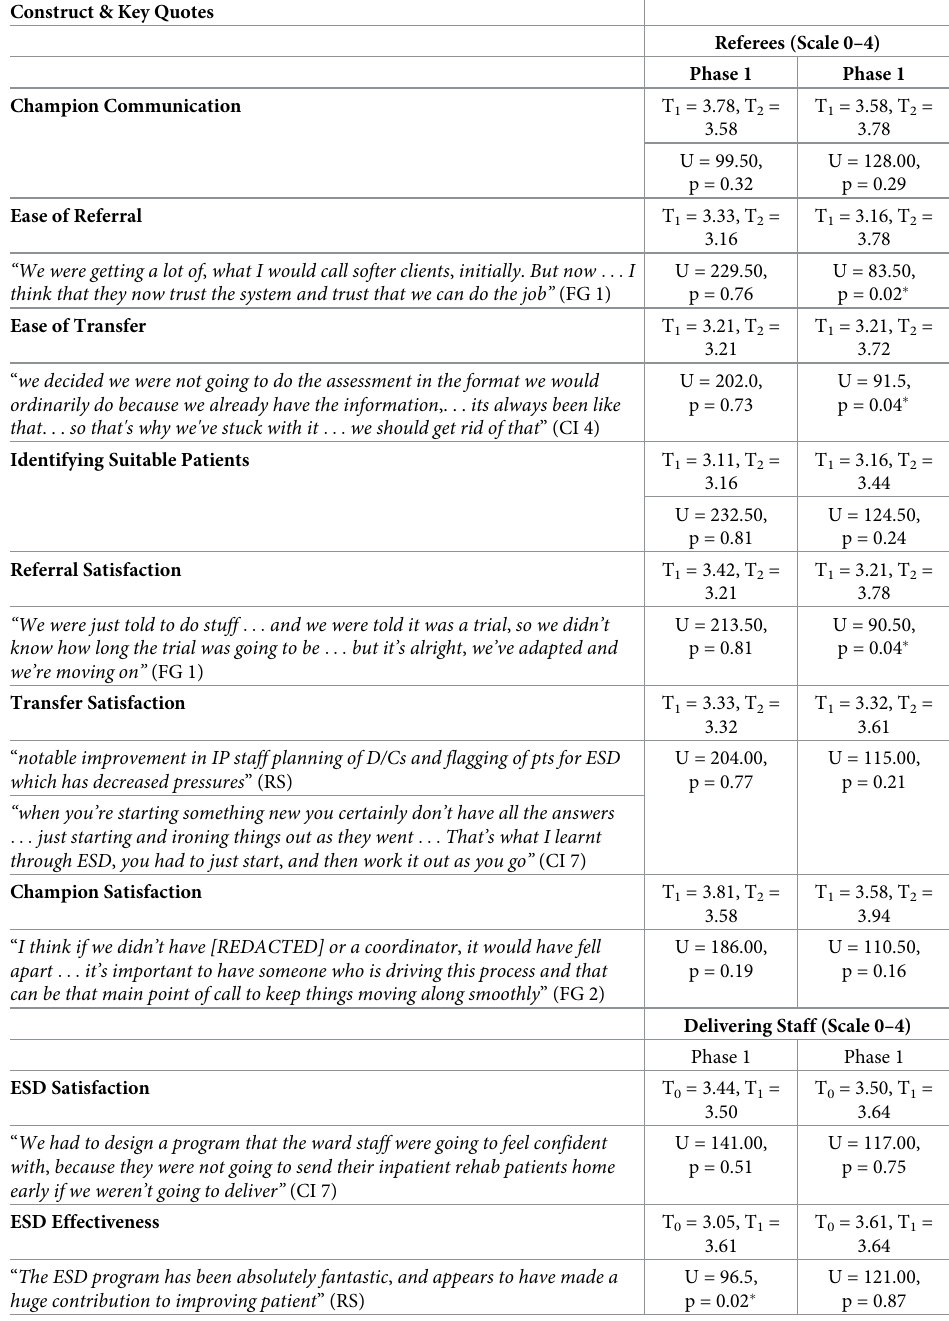
Table 5. Findings for process